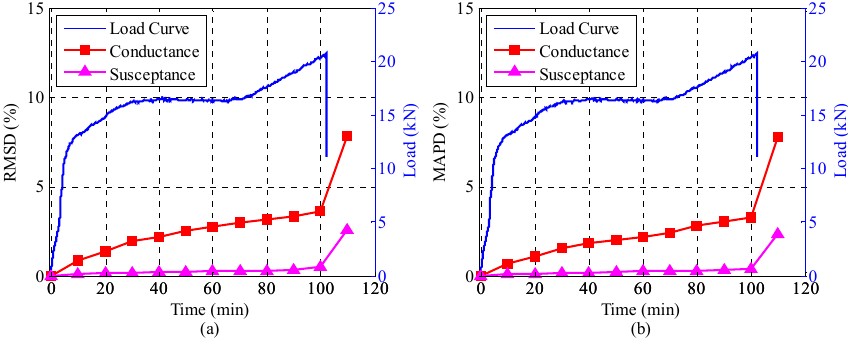
Figure 8. The damage metrics of the conductance and susceptance for SA-1 during the test. ( a ) root mean square deviation (RMSD), ( b ) mean absolute percentage deviation (MAPD).